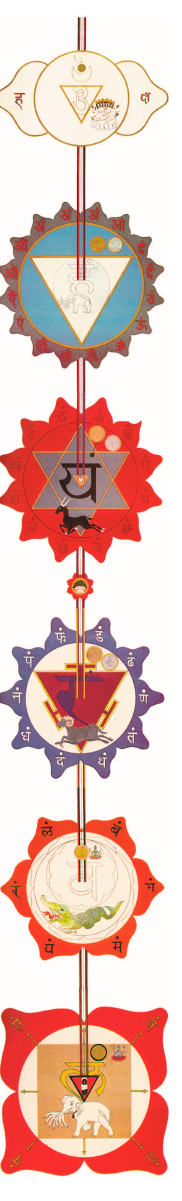
Figure 3. Six Cakras .